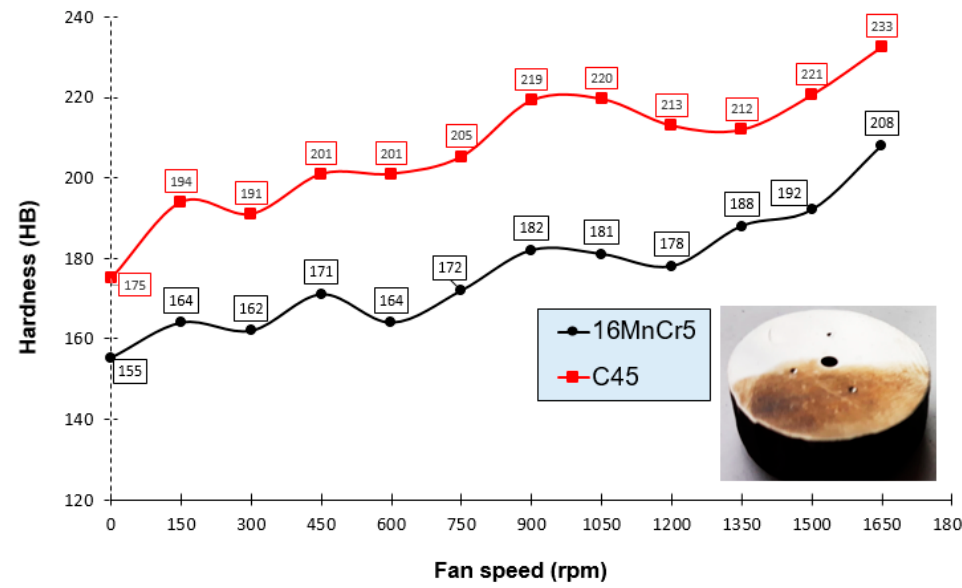
Figure 11. The distribution for hardness measurements for both materials (16MnCr5 and C45) as a function of fan speed for samples with dimensions 35 × 40 mm.